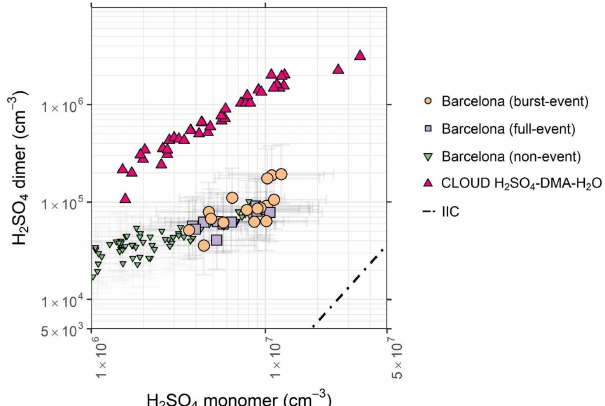
Figure 6. Sulfuric acid dimer concentration plotted against monomer concentration, showing burst-event periods (tan circles), full-event periods (purple squares), non-event periods (green in- verted triangles), and the ratio of sulfuric acid dimer:monomer in the CLOUD chamber for the H 2 SO 4 –H 2 O–DMA system (pink tri- angles) (Almeida et al., 2013). Dashed line represents the dimer concentration produced by ion-induced clustering in the chemical ionisation unit (Zhao et al., 2010). CLOUD chamber experiments were performed at 278 K and 38%–39% RH. Data are for hourly averages across NPF periods, typically within the hours 08:00– 16:00. Error bars represent systematic uncertainties in [H 2 SO 4 ] and [ ( H 2 SO 4 ) 2